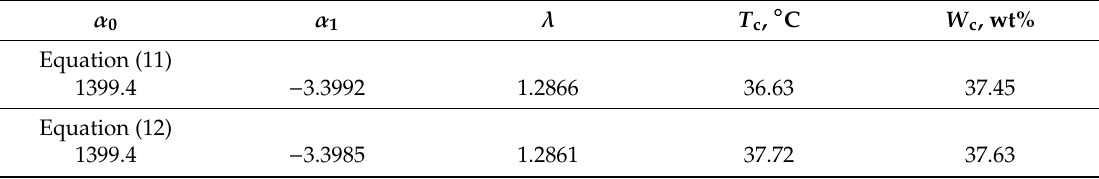
Figure 1. Experimental data and model predictions for the pyraclostrobin – isopropanol / cyclohexane system. The open circles and diamonds indicate the experimental data points for solubility and oiling out (binodal), respectively, adapted from [4]. Curve 1 represents the model ( µ l = µ s ) fit to solubility data using Equations (16) and (17). The square-well interaction parameters (listed in Table 1) obtained from this fit were used to further calculate the binodal (curve 2), spinodal (curve 3), and the gelation (curve 4) boundaries. The dotted lines are the curves obtained using Equation (11) and the solid lines are those obtained with Equation (12), respectively, for calculating η e ff . The dotted and solid lines for curve 4 are almost identical. Table 1. Best fit parameters for the pyraclostrobin – isopropanol / cyclohexanone system estimated through fitting the experimental data of Li et al. [4]. Parameters obtained using both the models for the first perturbative term of the Helmholtz free energy (i.e., η e ff through Equations (11) and (12)), are listed. Also given are the estimated critical temperature ( T c ) and critical concentration ( W c ). The calculations were performed with σ = 0.896 nm.